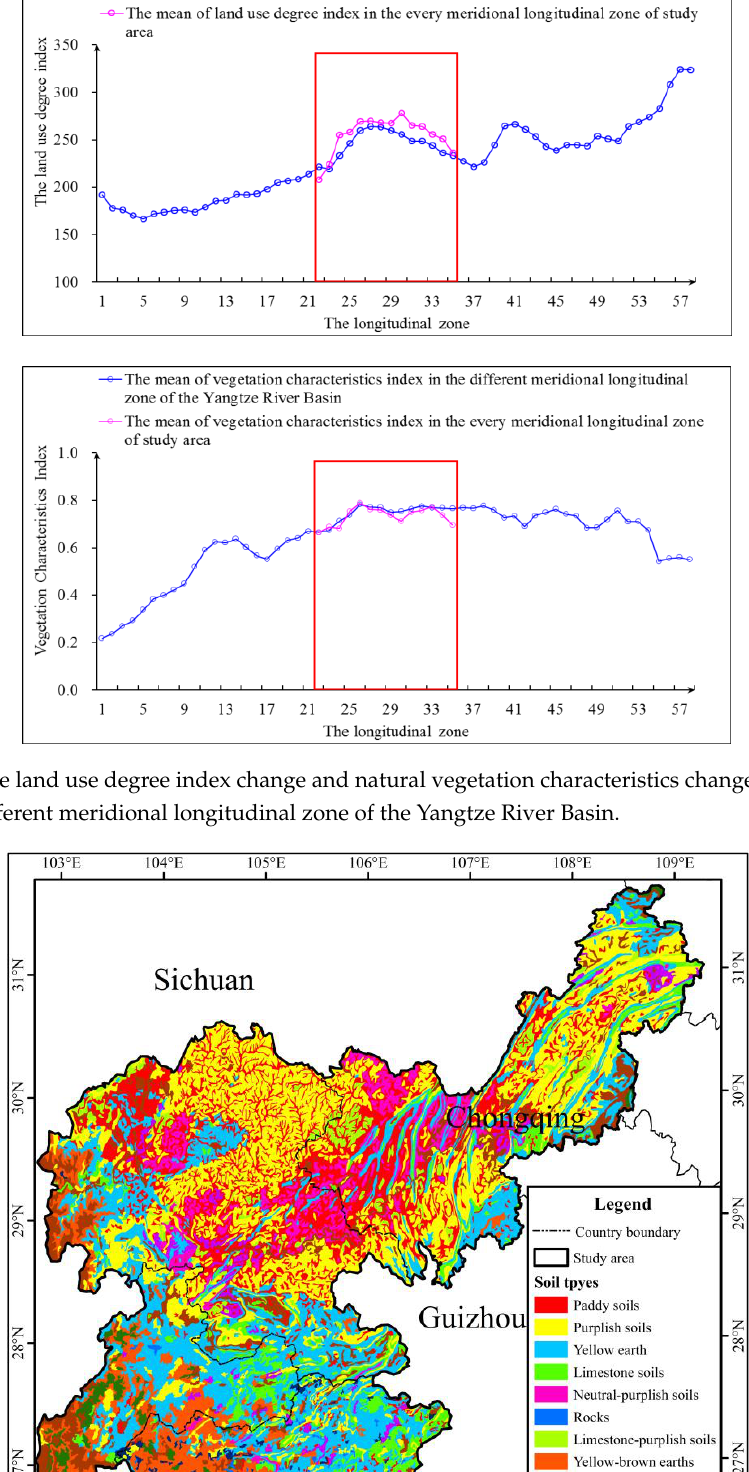
Figure 4. Map of main plant types distribution.